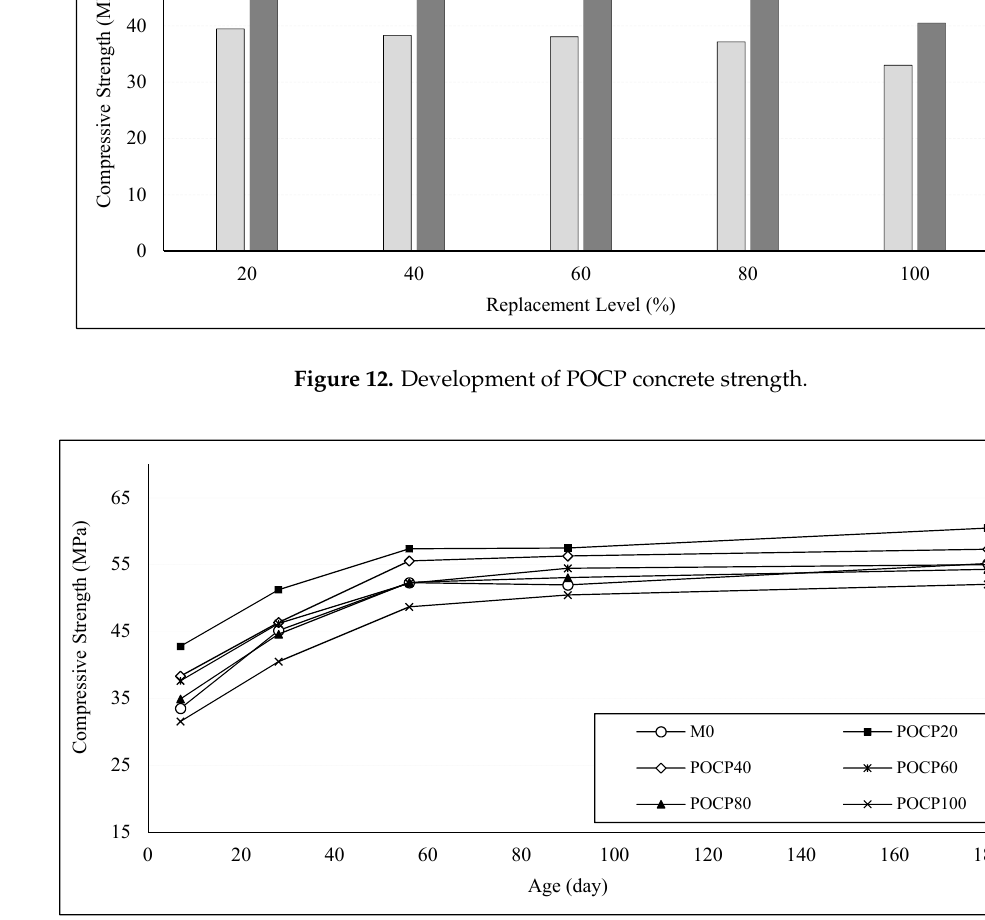
Figure 13. 28-day compressive strength of POC and POCP concretes.